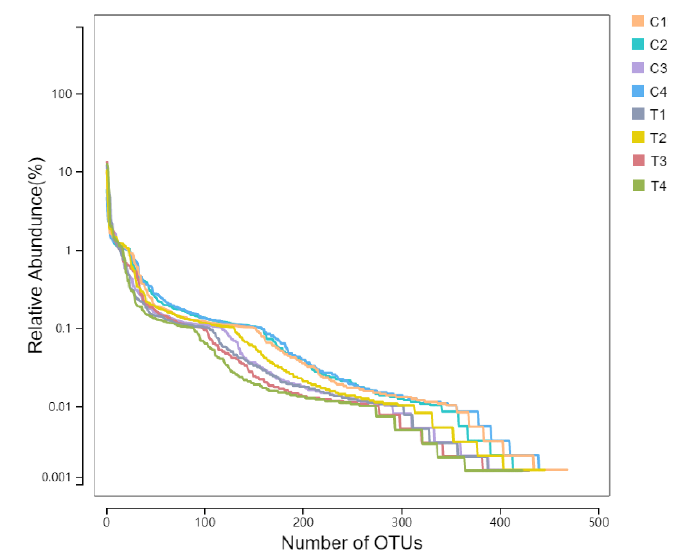
Figure 7. RANK curve of species.